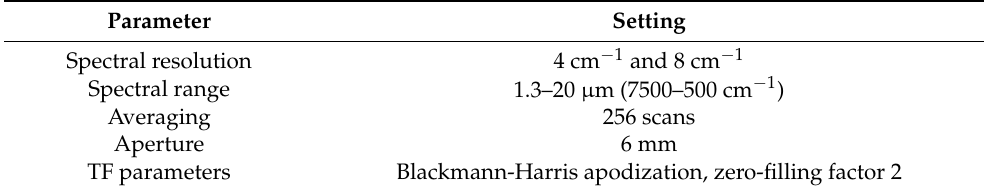
Table A5. Parameters used for the Bruker 80v FTIR spectrometer setup at